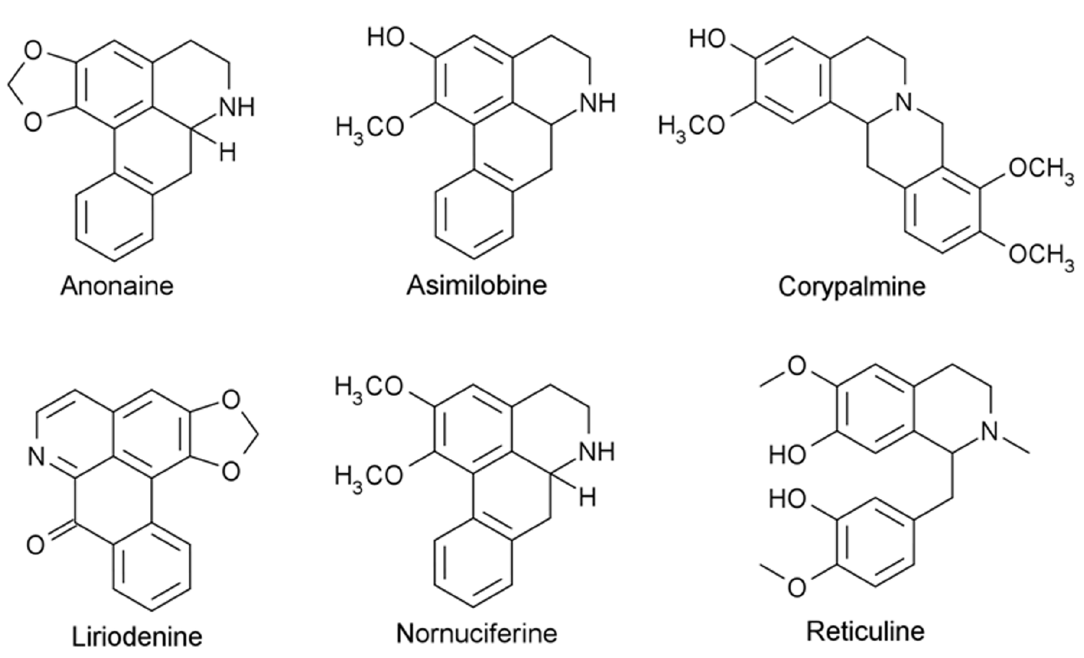
Figure 2 - Chemical structures of the compounds identi fi ed in the Annona squamosa